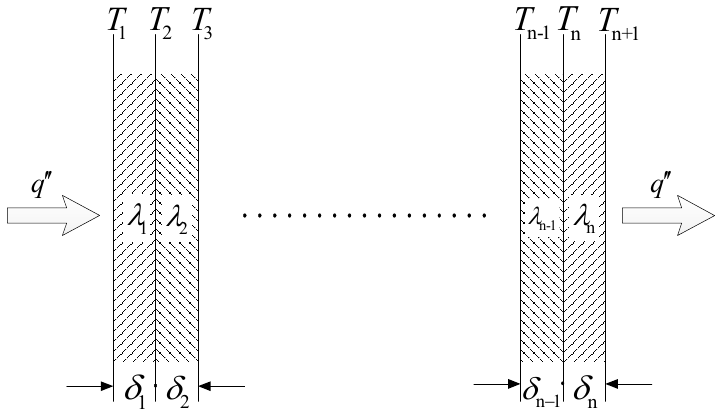
Figure 9. Schematic diagram of the conduction heat transfer in multi-layer